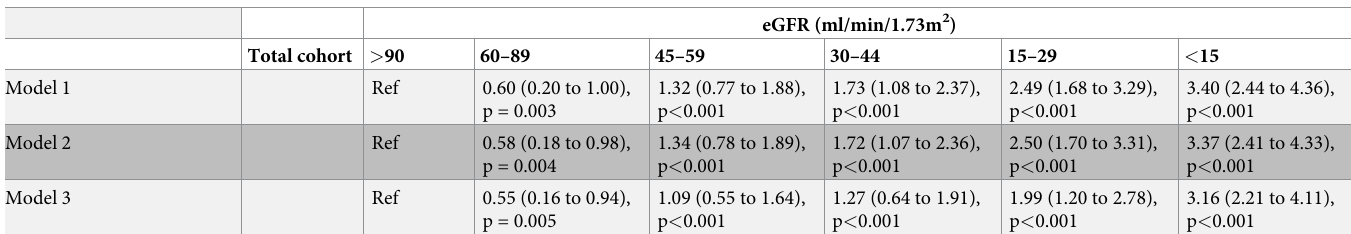
1.73m 2 . After adjustment for important confounders (such as age, gender, main diagnosis, and comorbidities) the groups with an eGFR below 45 ml/min/1.73m 2 remained significantly asso- ciated with 30-day mortality ( Table 2 ). Using multivariate regression the adjusted OR was 1.70 (95% CI, 1.05 to 2.75, p = 0.03) for 30–44 ml/min/1.73m 2 , 2.31 (95% CI 1.36 to 3.90, p = 0.002) for 15-29ml/min/1.73m 2 and 3.73 (95% CI 2.04 to 6.84, p < 0.001) for the lowest group ( < 15ml/min/1.73m 2 ), as compared to the highest eGFR group. The in-hospital mortality with eGFR < 15 ml/min/1.73m 2 was lower than in the group with a eGFR of 15–30 ml/min/1.73m 2 , with a relative small number of patients and events in both groups. Each decrease in eGFR of 10 ml/min/1.73m 2 was associated with a 15% increased risk of 30-day mortality (OR 1.15, 95% CI 1.09 to 1.22, p < 0.001) ( Table 3 ).When adjusted for the selected biomarkers Hemoglobin (Hb), C-reactive Protein (CRP), and Copeptin individually, eGFR remained significantly associated with 30-day mortality. When adjusted for all biomark- ers at once the association with eGFR was no longer apparent ( S2 Table ).